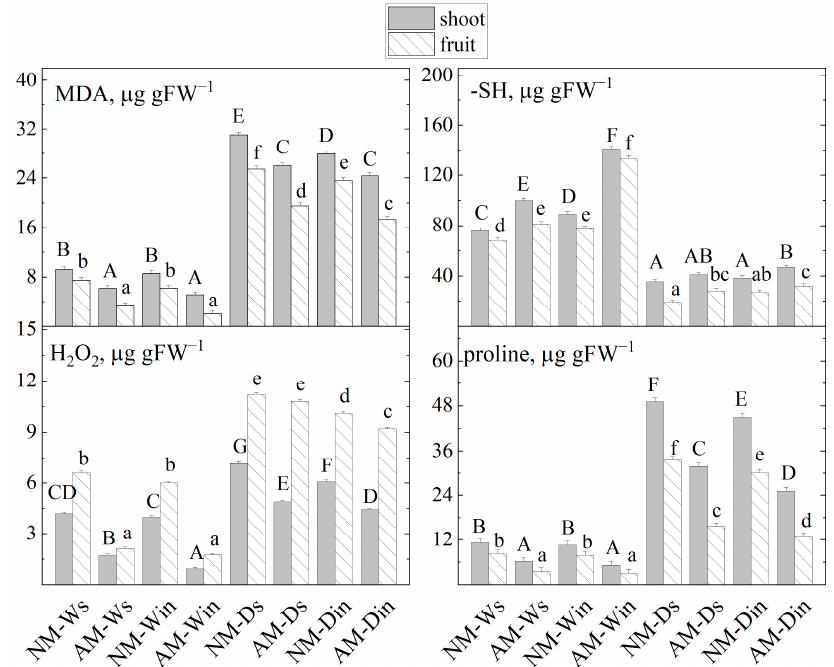
Figure 3. The levels of stress markers identifying the plants’ tolerance to drought—MDA, -SH groups, H 2 O 2 , and proline in P. peruviana (leaves and fruits): non-mycorrhizal ( NM ), AMF-inoculated ( AM ), well-watered ( W ), drought-stressed ( D ), seed-propagated ( s ), and in vitro propagated ( in ) plants. Values are mean ± SE, n = 3; common letters within a graph show no significant differences as determined by Fisher LSD test ( p ≤ 0.05) following ANOVA. The statistical analyses of leaves (uppercase) and fruit (lowercase) were performed separately. Inoculation of plants with Claroideoglomus claroideum reduced the level of oxidative stress indicated by a slight decrease in the content of H 2 O 2 , MDA, and proline, but a sig- nificant increase in the amount of -SH groups, both in the leaves and fruits of micro propagated and seed-propagated P. peruviana plants. Through the growth of extraradical AMF fungal mycelia, the AMF symbiosis facilitated plants in efficiently absorbing water and mineral nutrients from the soil. The greater water status in AMF-inoculated P. Peru- viana plants decreased the harmful impact of the drought stress leading to the lower ac- cumulation of proline and hydrogen peroxide [47,48]. There is evidence in the literature of both an increase [49] and a decrease [50,51] in proline and hydrogen peroxide content in inoculated plants compared to non-inoculated ones. Therefore, the level of stress markers depends on the type of AMF and plant species used. The results agrees with previous findings in trifoliate orange and Erythrina variegate plants under drought stress [50,51]. It was determined that the negative effects of drought were less pronounced in leaves and fruit of adapted, in vitro propagated plants regarding the levels of the exam- ined stress markers by comparing the changes in their levels in leaves and fruit of plants grown from seeds. Similar conclusions were made in earlier studies using Coleus forskohlii (Willd.)[52], which pointed out a similar model in different plants to deal with stressful conditions of the environment such as drought. The –SH groups, MDA, and proline levels were higher in the aboveground parts, but the H 2 O 2 content was significantly higher in the fruits in all investigated treatments. Hydrogen peroxide is involved in the oxidation processes needed to start and promote the ripening of the fruit. During the ripening of peppers ( Capsicum annuum L.) and to-